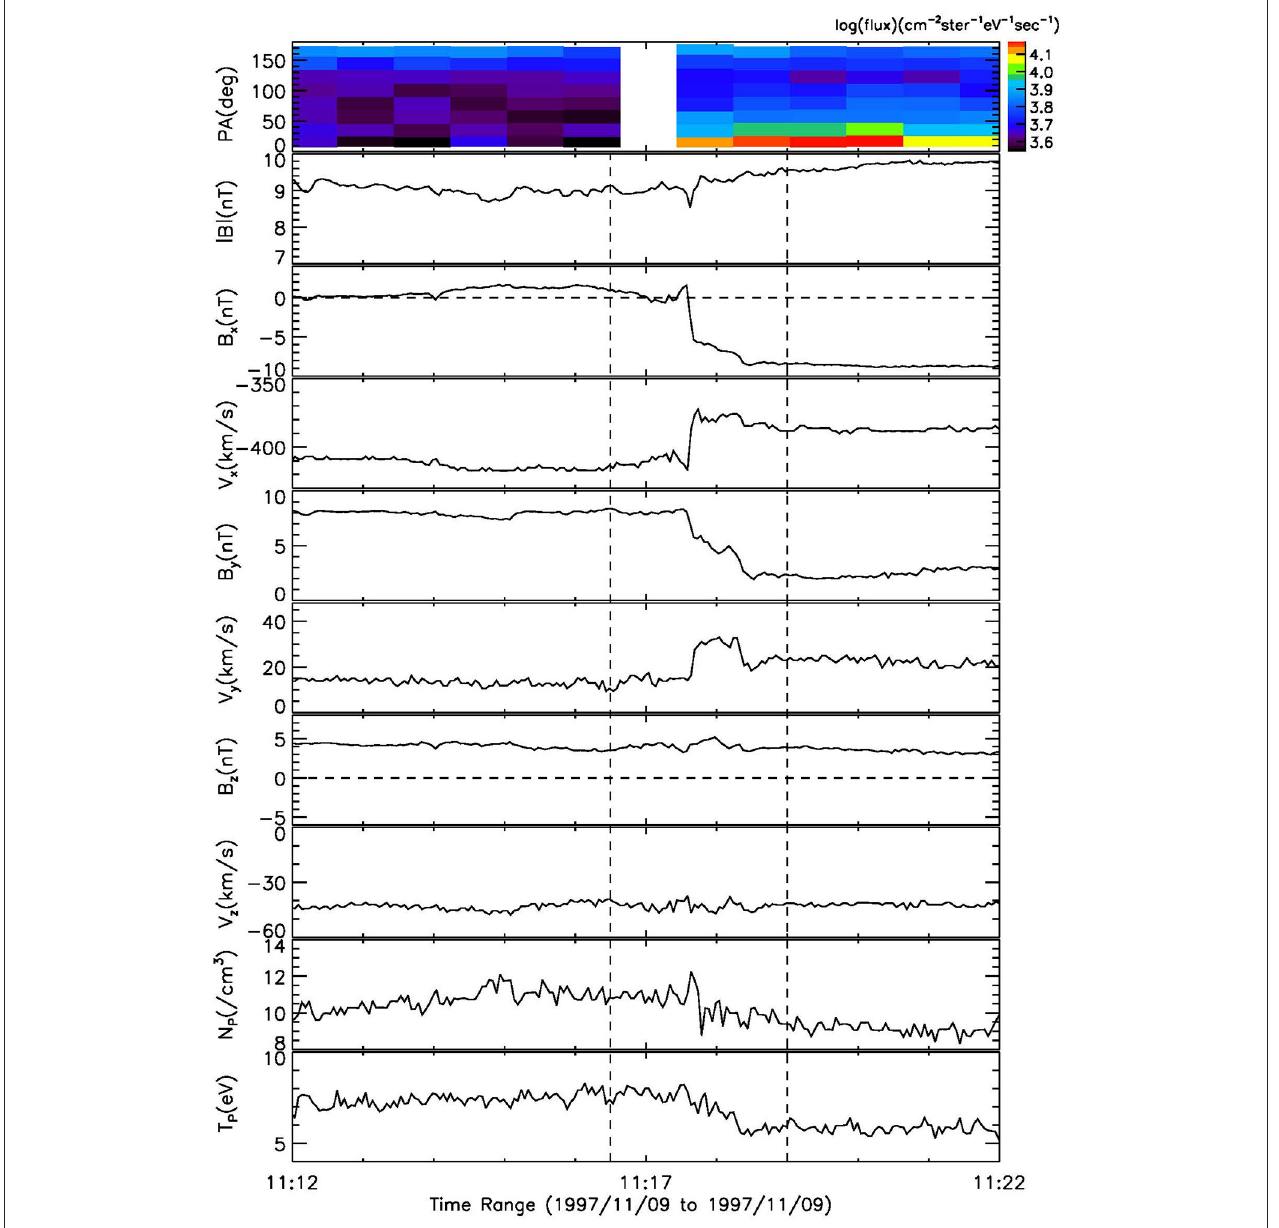
FIGURE 7 | The reconnection exhaust around 11:18 UT November 16th measured by Wind. The format of the figure is same as Figure 2 .